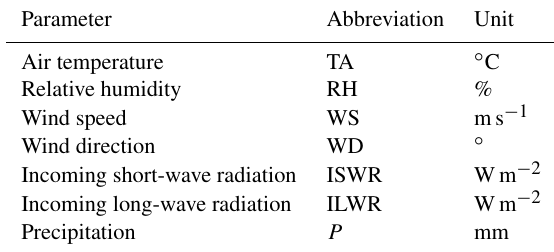
Figure 1. Flüela snow heap after coverage with sawdust in autumn 2015. Table 1. Measured meteorological